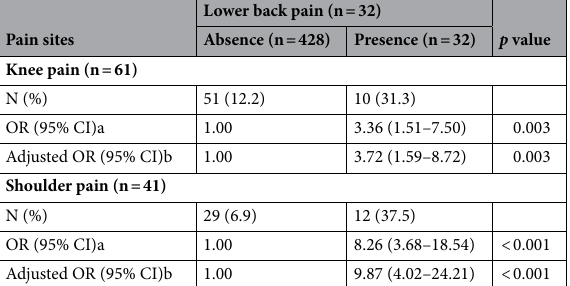
Table 3. Lower back pain associated with knee pain and shoulder pain among elementary school age badminton players. OR odds ratio, CI confidence intervals. a Crude model. bAdjusted for gender (male or female), age (7–8, 9–10 or 11–12 years), BMI (body mass index), badminton experience (< 1, 1 to < 3 or ≥ 3 years), hours per day (≤ 2.5, or > 2.5 h), days per week (≤ 3, 4–5, or 6–7 days), total hours per week (≤ 11, or > 11 h), warming up (yes or no) and cool down (yes or no).